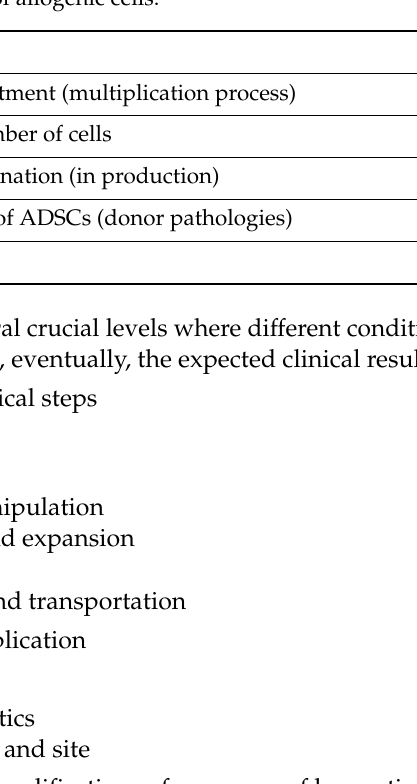
Table 1. Principal advantages of allogenic